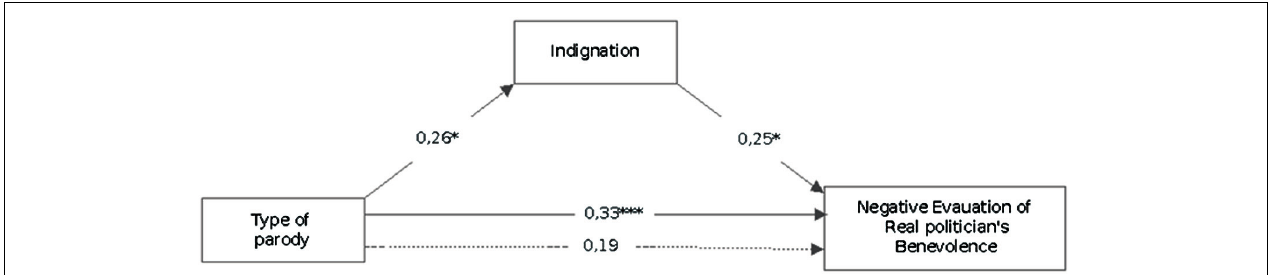
FIGURE 1 | Mediational regression analyses of type of video and indignation on negative evaluation of character’s benevolence. The type of Video variable was processed as a progressive number 1 = imitation, 2 = surface, 3 = deep associated to the progressive “severity of parody,” so the positive relation must be read as follows: when “severity of parody” increases indignation increases too ∗ p < 0.05; ∗∗∗ p < 0.001. Solid lines between variables denote direct paths between two variables. Dotted lines denote paths when moral and negative emotions are included as mediator. Values denote standardized Beta